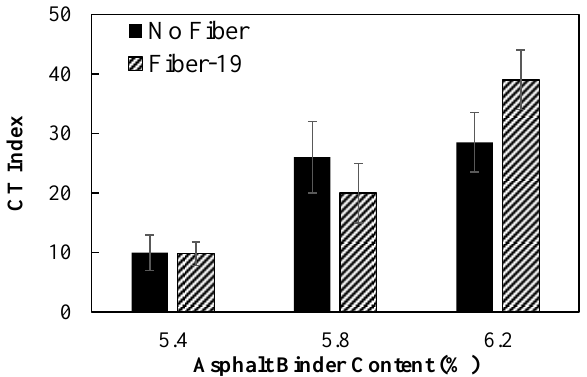
Figure 8. CT index values for mixtures with and without fibers at different asphalt contents.